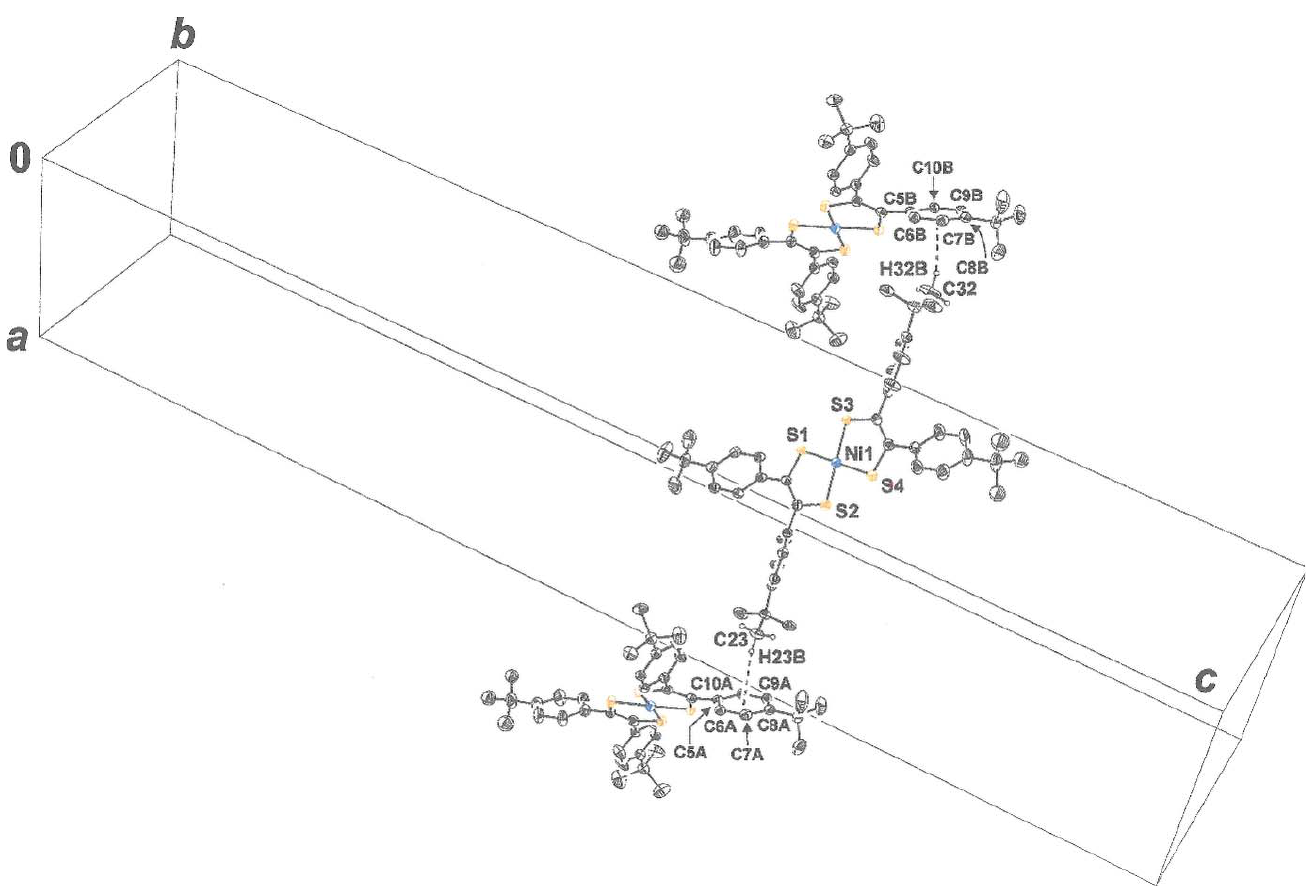
Figure 4 Intermolecular arene centroid (cid:3)(cid:3)(cid:3) H–C t Bu interactions, shown as dashed lines, that guide the packing arrangement for 1 . The H23 B (cid:3)(cid:3)(cid:3) C5 ! C10 centroid and H32 B (cid:3)(cid:3)(cid:3) C5 ! C10 centroid contacts are 3.00 and 2.90 A˚ , respectively. Symmetry transformation used to generate equivalent molecules: 3 (cid:2) 1 (cid:2) x , 1 (cid:2) z + y , 5 2 2 4